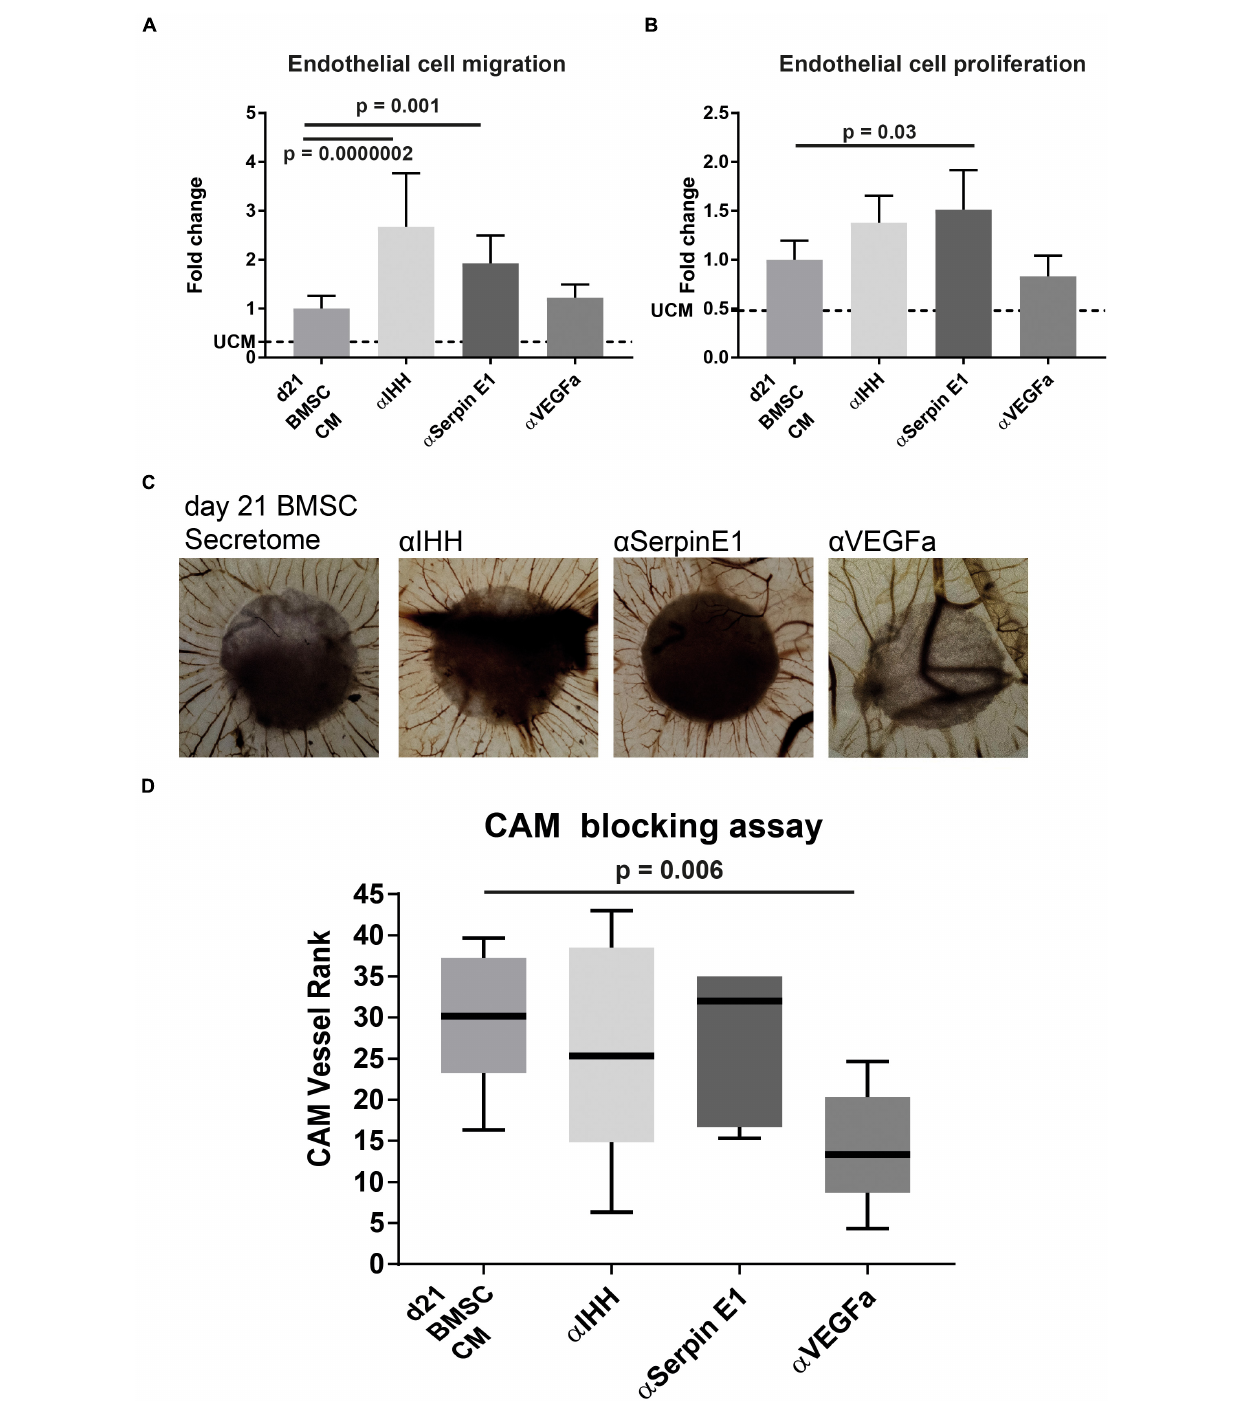
FIGURE 5 | Blocking IHH or Serpin E1 increased angiogenic potential of CM of chondrogenically differentiated BMSC in vitro and showed no effect in vivo CAM assay. (A) Quantification of endothelial cell migration assay comparing the impact of pre-incubation of CM with blocking antibodies for factors of interest. Values are normalized to the BMSC-CM condition. UCM depicts the un-conditioned medium. (B) Quantification of endothelial cell proliferation assay comparing the impact of pre-incubation of CM with blocking antibodies for factors of interest. Values are normalized to the BMSC-CM condition. UCM depicts the un-conditioned medium. (C) Images of chick chorioallantoic membrane incubated for 72 h with CM (blocked for 30 min) soaked 5 mm filter disks. Filter circles were placed on a vessel free area on day 7 of the chick development. (D) Boxplot depicting the ranking of the angiogenic potential (lowest = 1 highest = 45: average of 3 independent observers: box = interquartile range, whiskers + 1–99%). N = 5 per condition. A & B were performed in two batches each pooling 3 donors; n = 3. Significance was determined by mixed-linear model with Bonferroni post hoc